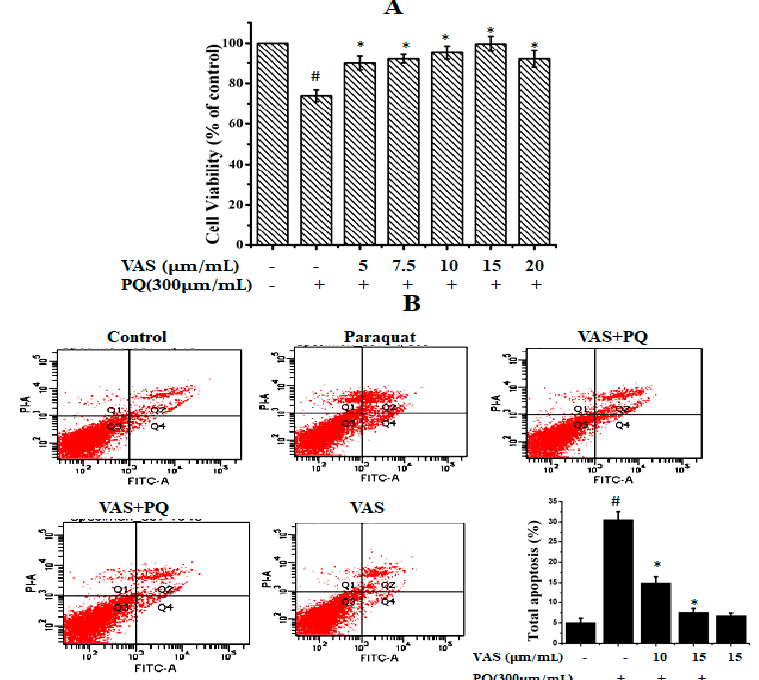
Figure 1. E ff ect of paraquat and vasicinone on SH-SY5Y cell viability. ( A ) Cells were pre-incubated with di ff erent concentrations of vasicinone for 24 h, and paraquat (300 µ M) was added for an additional 24 h. Data are expressed as the percentage of the untreated control ± SD, n = 3. # p < 0.01, significantly di ff erent from control cells; * p < 0.01, compared with paraquat-treated group by one-way ANOVA. ( B ) Cell apoptosis and necrosis detected by flow cytometry. The results are shown as the percentage of the means and SDs for three independent experiments. # p < 0.01, significantly di ff erent from control cells; * p < 0.01, compared with paraquat-treated group. VAS: Vasicinone; VAS + PQ: Vasicinone + Paraquat